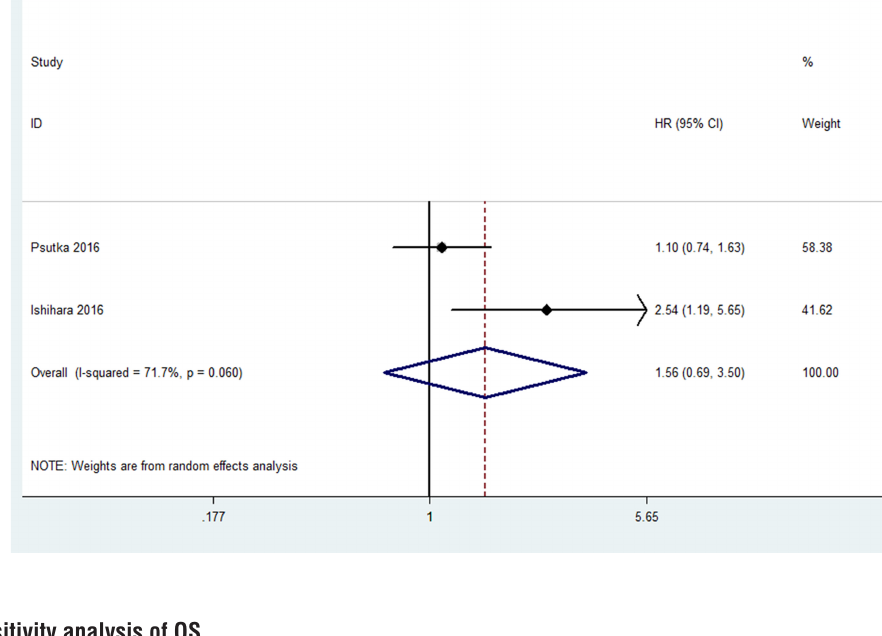
Figure 4 - Sensitivity analysis of